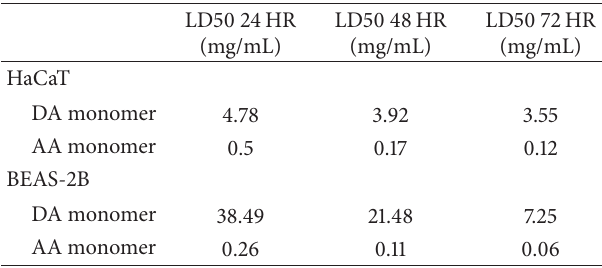
Table 1: LD50 values for the DA and AA monomers for 24-, 48- and 72-hour exposures for the HaCaT and BEAS-2B cellular lines.